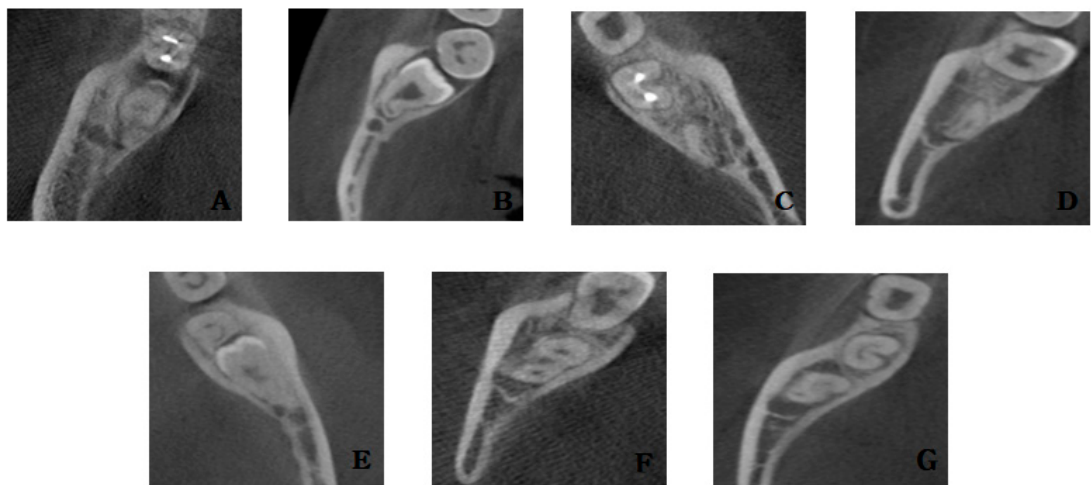
Figure 5. Relationship between the inferior alveolar canal and roots in cone beam computer tomography views: ( A ) root darkening in panoramic view, ( B ) root deflection in panoramic view, ( C ) root narrowing in panoramic view, ( D ) dark line in apex in panoramic view, ( E ) loss of white line in panoramic view, ( F ) inferior alveolar nerve (IAN) narrowing in panoramic view, and ( G ) IAN diversion in panoramic view.